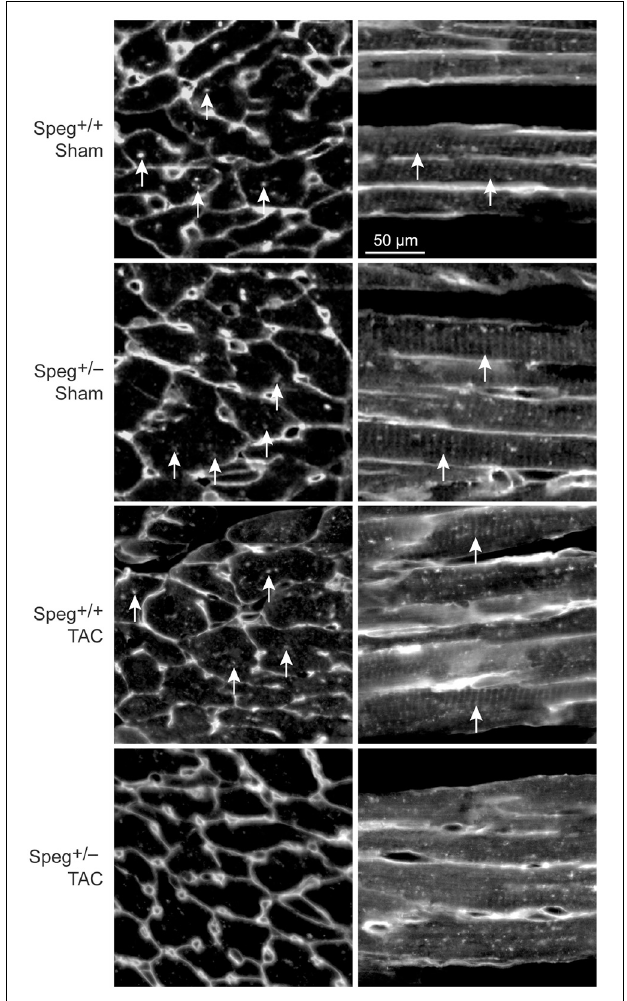
FIGURE 6 | Altered transverse tubular structure in cardiomyocytes from the left ventricle of Speg + / − mice post-TAC. Surface and transverse tubular membrane staining of sections from the left ventricle of Speg + / + and Speg + / − hearts, 4 weeks after sham or TAC surgery. Confocal images of cell membranes labeled with wheat germ agglutinin (WGA) are shown in transverse (left panels) and longitudinal (right panels) sections. Arrows point to transverse tubule structures. Scale bar, 50 µ m.